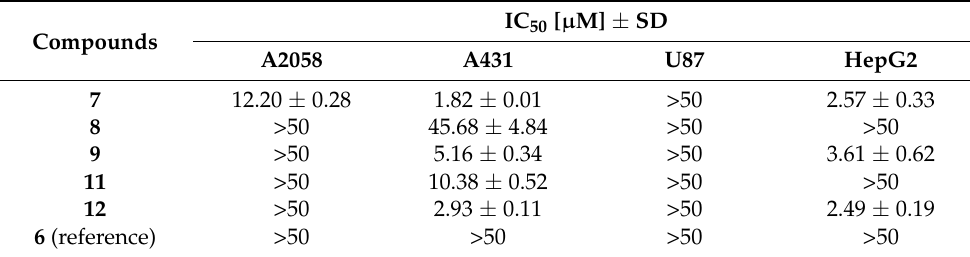
Table 2. Cytostatic activity of ferrocene-containing pyridazinones 7 , 8 , 9 , 11 , and 12 , and the reference 4,5-diphenylpyridazin-3(2 H )-one 6 , expressed in IC 50 values on four human tumor cell